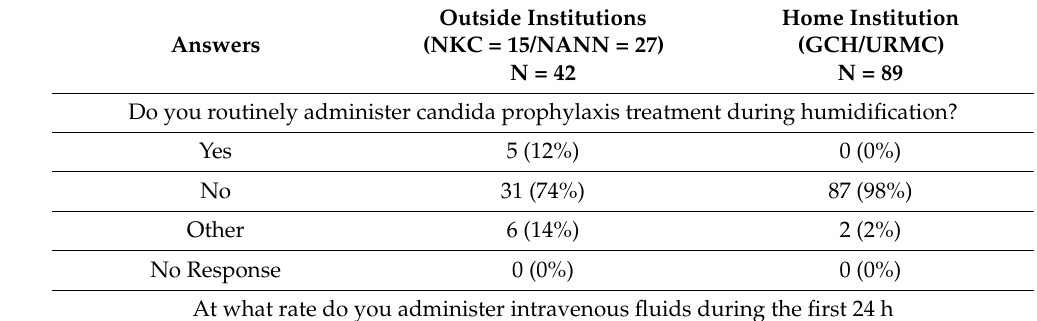
Table 4. Survey responses related to secondary